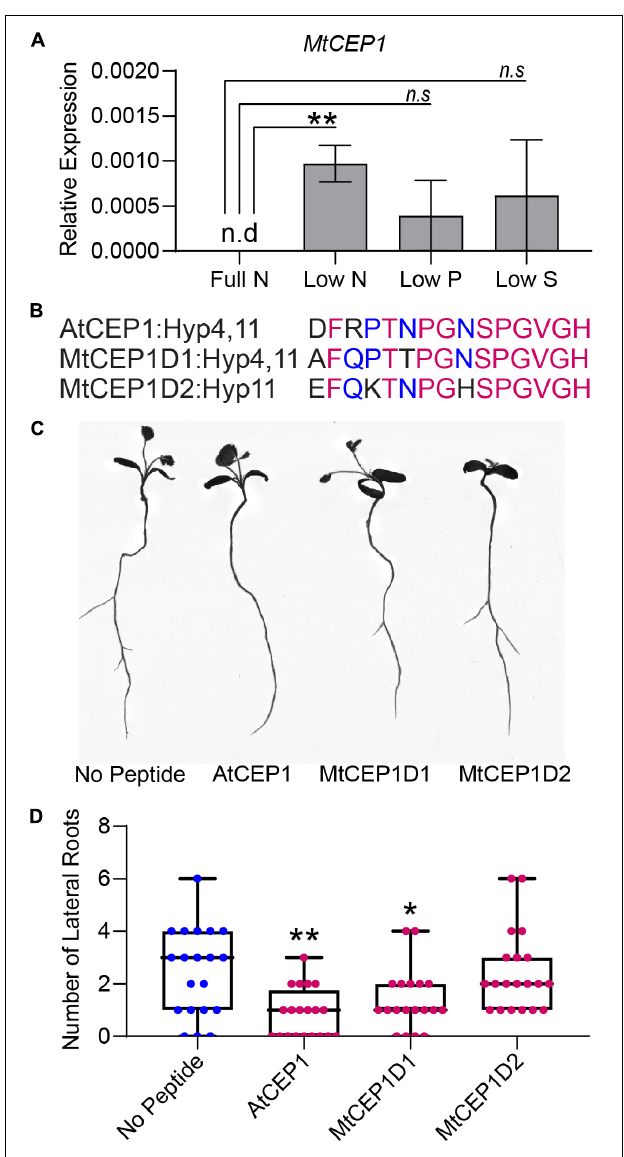
FIGURE 2 | Macronutrient stress responsive expression of CEP1 and effects of synthetic peptides on root system architecture in Medicago truncatula . (A) Relative MtCEP1 transcript abundance in M. truncatula seedling roots deprived of a specific macronutrient for 48 h. Transcript levels were measured by qRT-PCR, normalized to two housekeeping genes, UBC and PTB, and expressed relative to the level of MtCEP1 transcript at full Nitrogen (Full N, 6 mM Nitrogen). Data are averages of three biological replicates in each case. Error bars represent SEM. Student’s t -test * p < 0.05. Note no MtCEP1 transcripts were detected in two biological replicates under low-P and low-S treatments. MtCEP1 was not detected under full N conditions. (B) Sequences of peptides used in this study. Magenta indicates amino acid residues conserved between all three sequences and blue represents residues conserved between AtCEP1 and MtCEP1D1. Prolines in the 4th and 11th positions of each peptide were hydroxylated. (C) Representative root scans showing change in root architecture of M. truncatula Jemalong A17 seedlings treated with 1 µ M peptide compared to no peptide controls. (D) Effect of 1 µ M peptide application on lateral root number in M. truncatula Jemalong A17 seedlings 7 days post germination. One-way ANOVA followed by Dunnett’s multiple comparison test * p < 0.05, ** p <